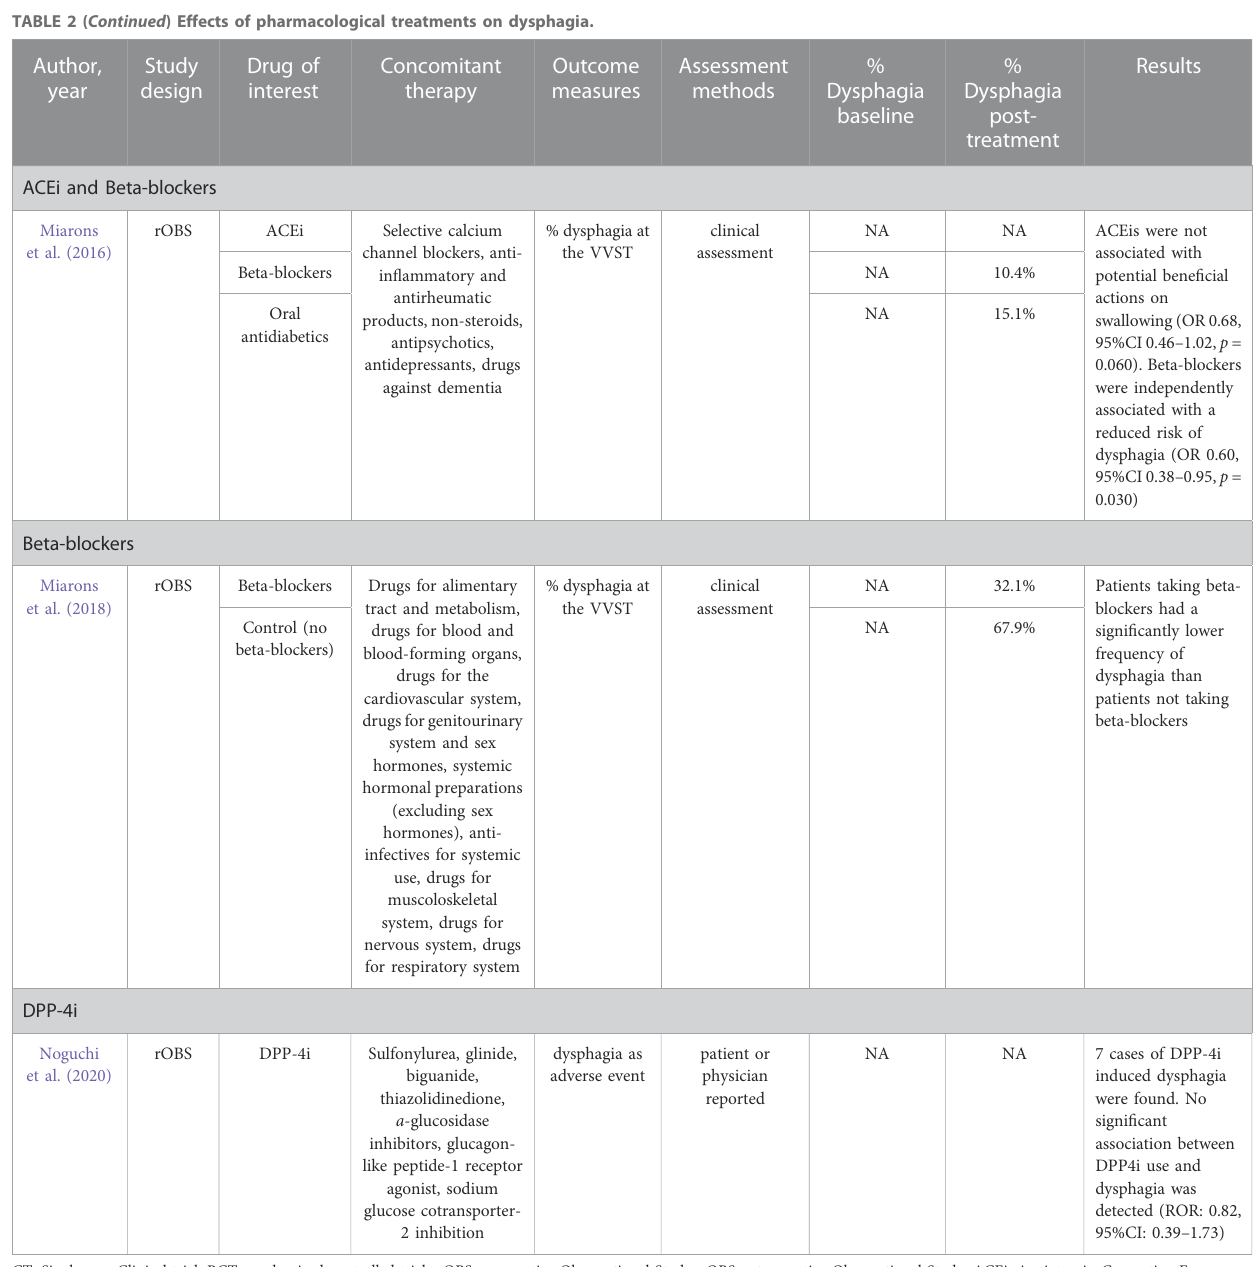
Supplementary Figure S3; Supplementary Table S4 show the results of the methodological assessment of included studies using the RoB2 and the ROBINS-I assessment tools. Risk of bias was on average high, with only one study classi fi ed as having low risk of bias (Nakashima et al., 2011). Concerning RCTs analyzed with ROB2, risk of bias was classi fi ed as low in one study (Nakashima et al., 2011) for two of the three outcomes of interest and high for the remaining outcome, moderate in one study (Lee et al., 2015), and high in three studies (Arai et al., 1998a; Nakayama et al., 1998; Kano et al., 2016). Most critical domains were related to the randomization process